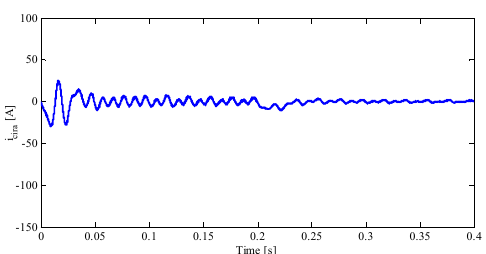
Figure 15. Circulating current of MMC in phase “a” with parameter variations.